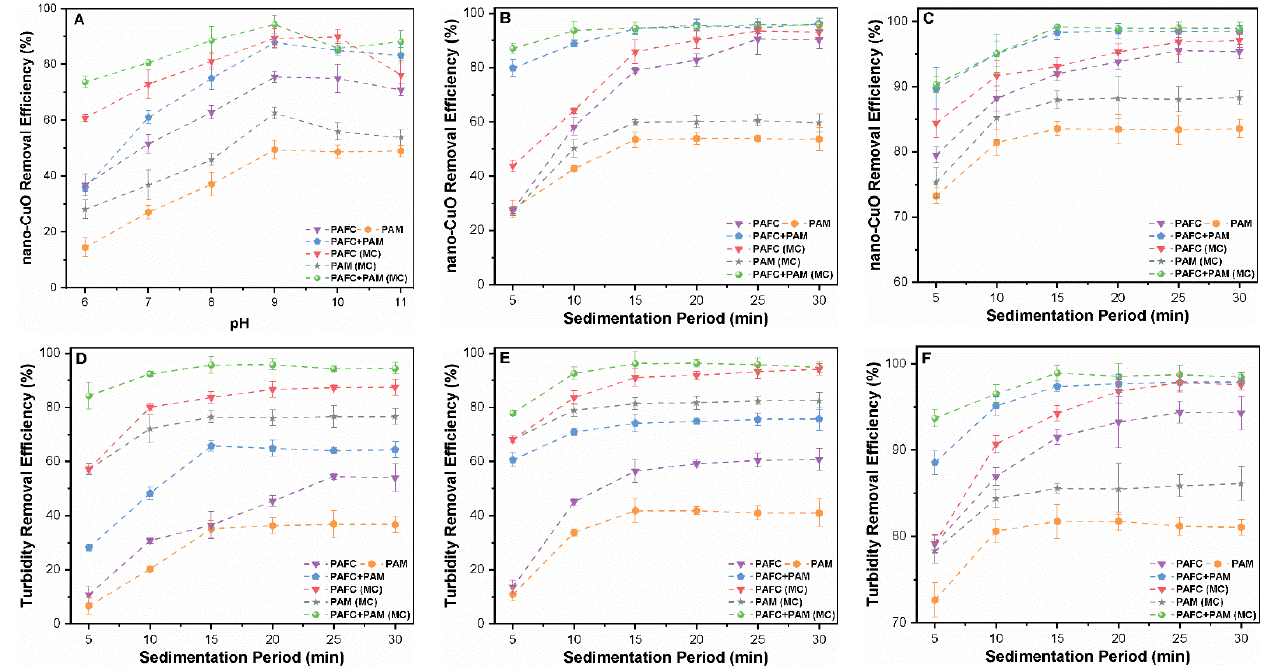
Figure 3. Influence of settling time (5–30 min) on the removal efficiency of nano-CuO and turbidity for various mass concentrations ( A , D ) 1 mg/L, ( B , E ) 2.5 mg/L and ( C , F ) 10 mg/L.